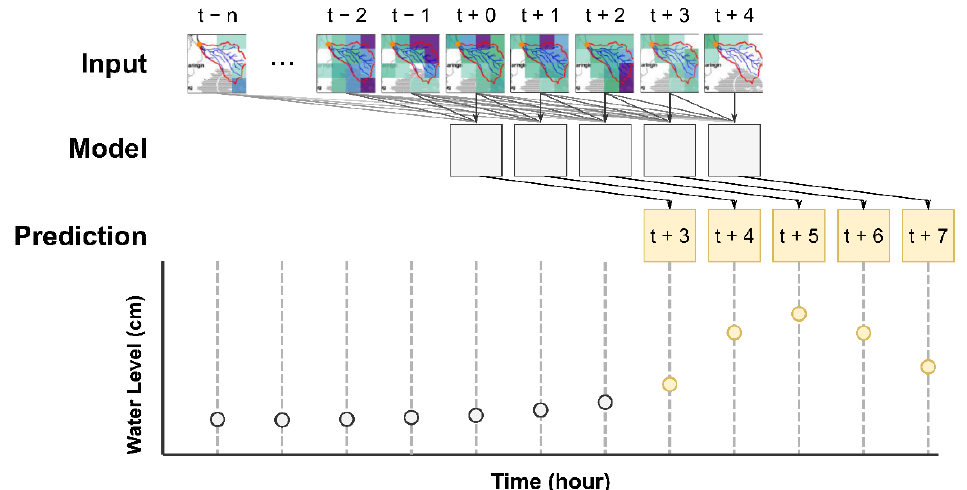
Figure 5. Temporal forecasting scheme.